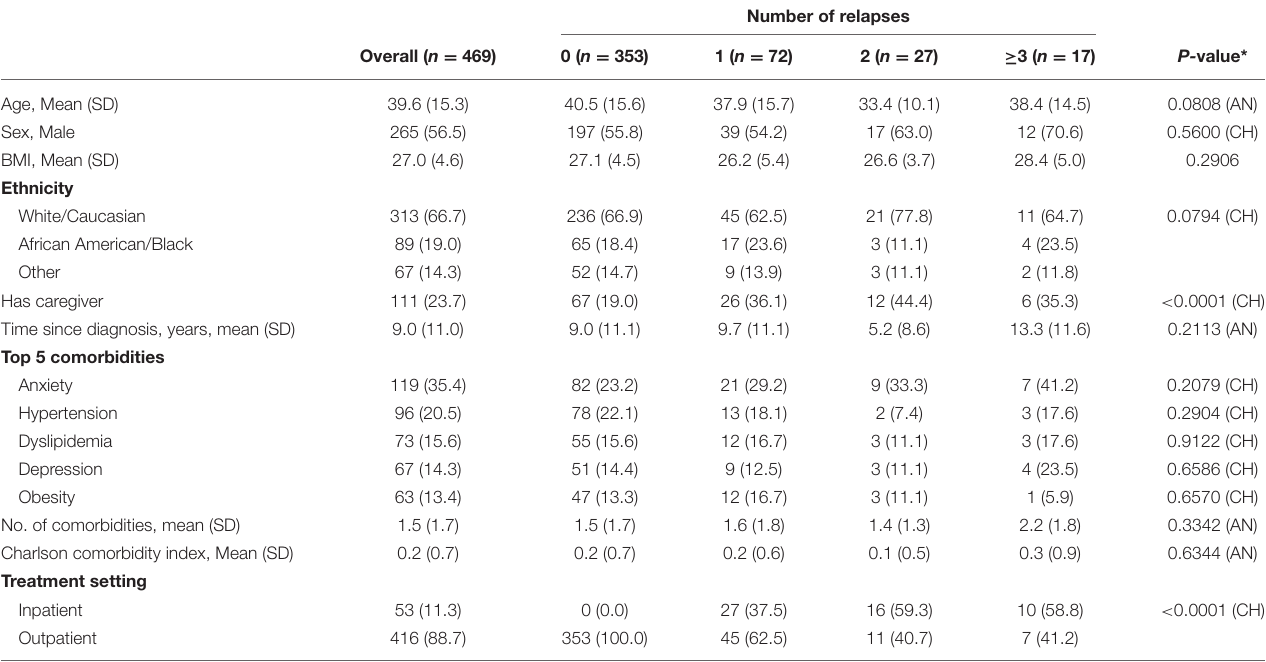
TABLE 1 | Patient demographics and